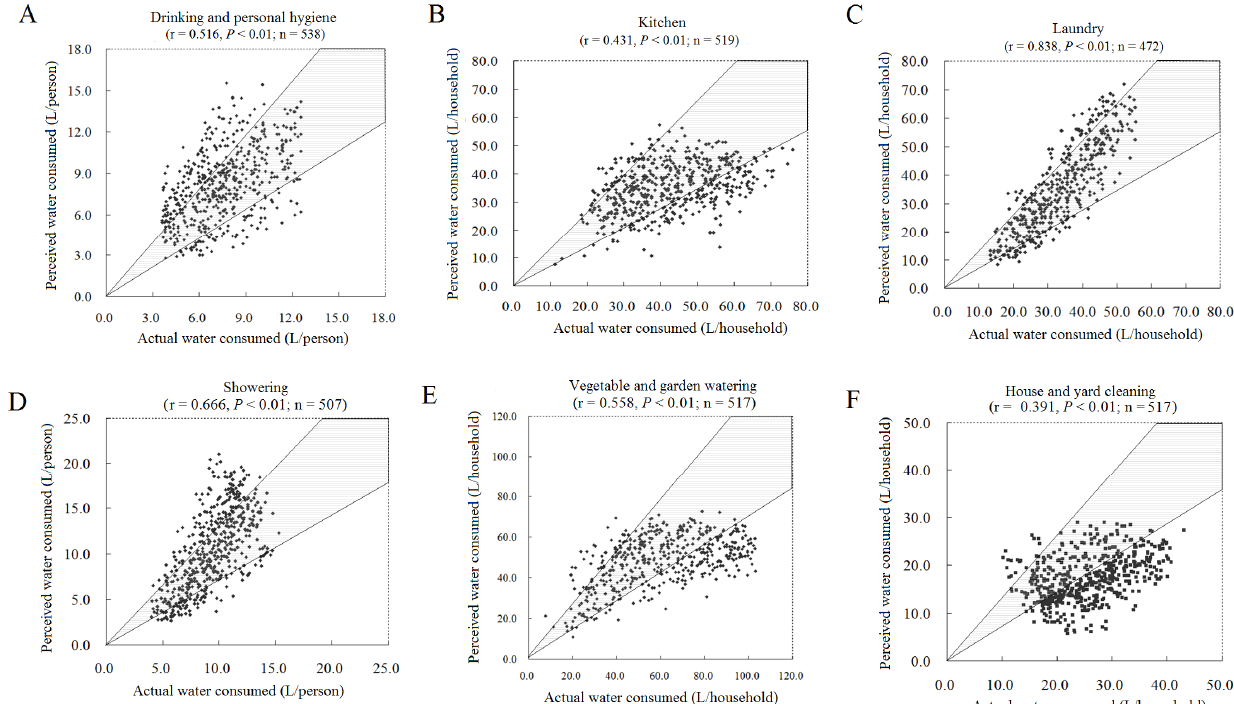
Figure 4. Perceived and actual water consumed of different water use